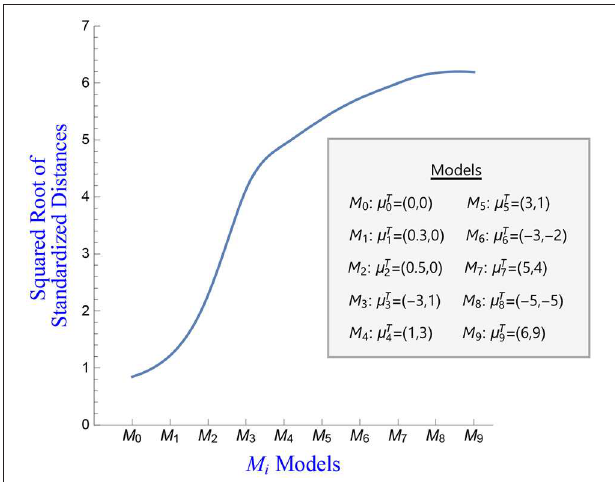
FIGURE 6 | Squared root of the standardized estimates of the distances between model ˆ F and the various fitted models. TABLE 1 | Estimates of the distances for ten different models and their associated standard deviations. Models